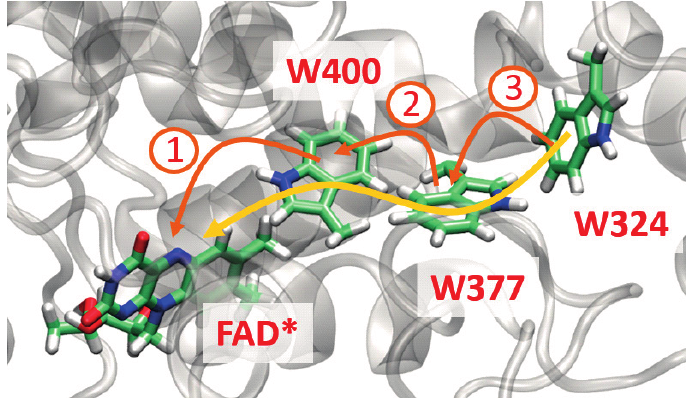
Figure 12. Photoactive site of Arabidopsis thaliana cryptochrome highlighting electron migration from W324 to the excited flavin cofactor (FAD*). Two limit mechanisms are shown: a fully coherent superexchange mechanism (in yellow) or an incoherent hopping mechanism (in